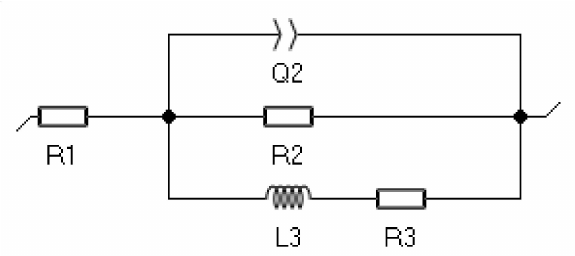
Figure 9. An equivalent circuit representing the impedance spectra of the investigated materials.